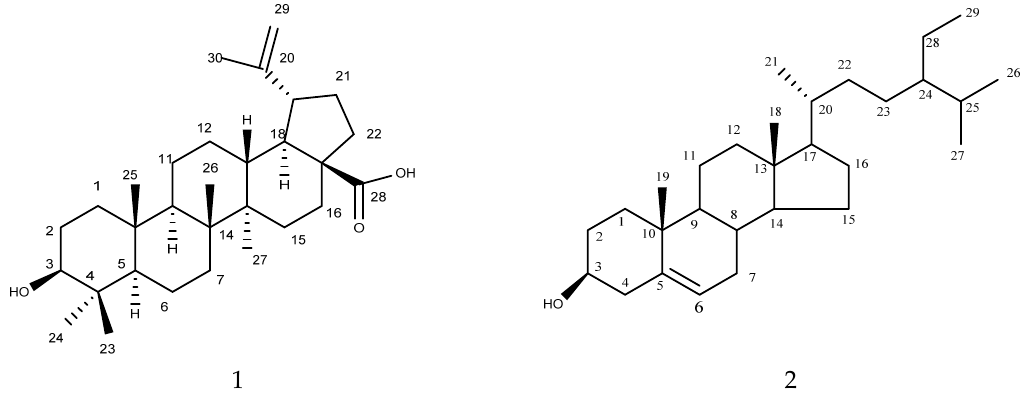
Figure 1. Isolated compounds 1 (betulinic acid) and 2 ( β -sitosterol) from L. acacia .